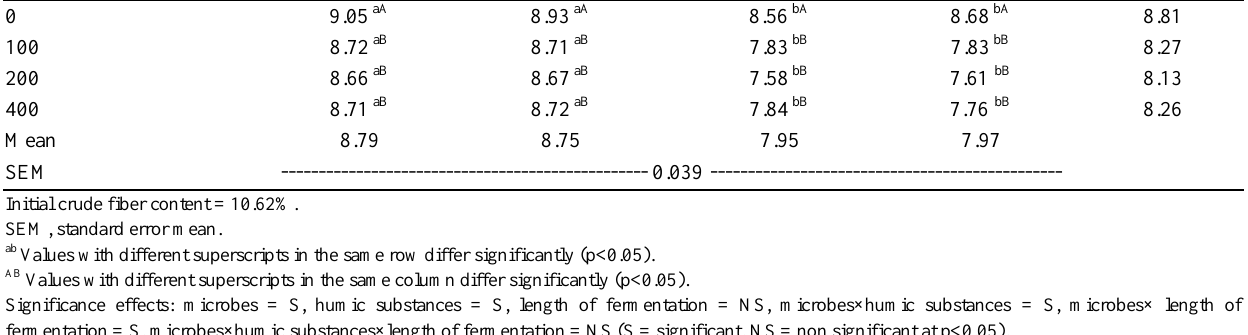
Table 2. Effects of fermentation on crude fiber content (%) Level of humic substances